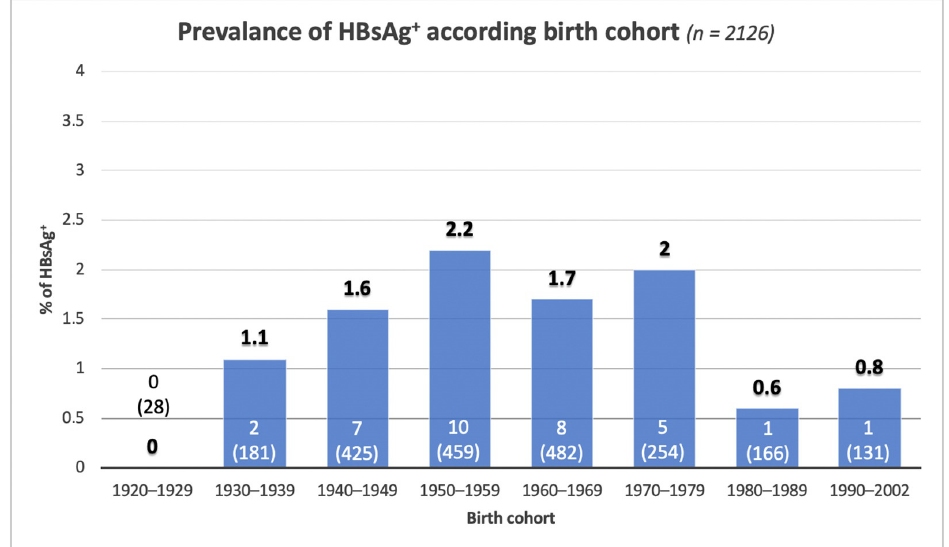
Figure 3. HBsAg seroprevalence, according to the birth cohort. In columns: numbers in parenthesis indicate the total number of screened subjects; number not in parenthesis indicate the number of positive cases.